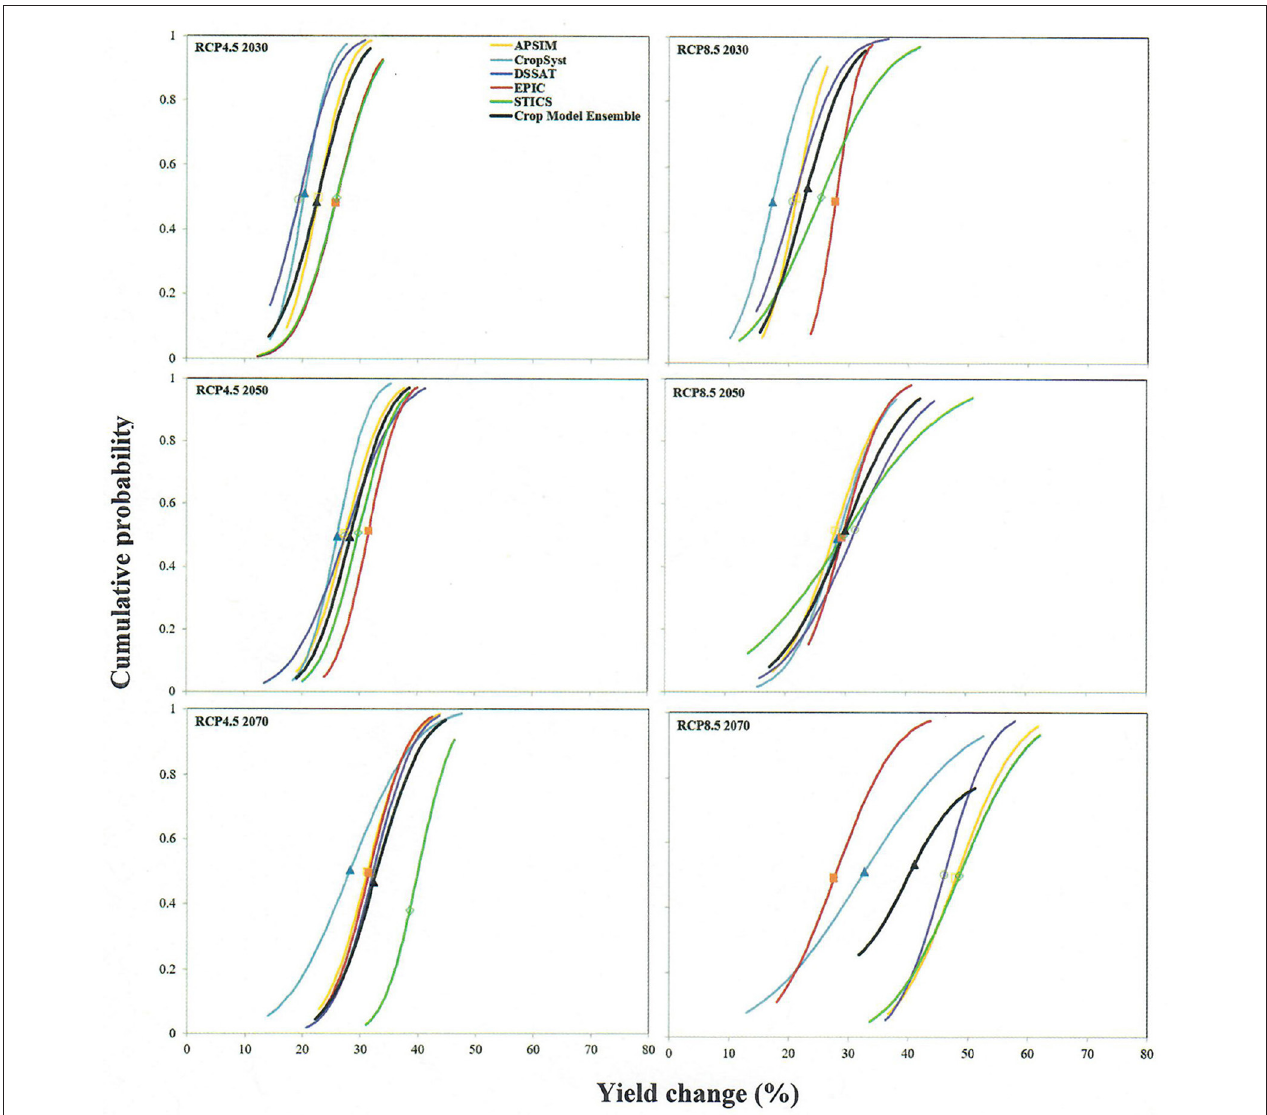
FIGURE 1 | Cumulative probability distribution for simulated winter wheat yield changes during three 31 year time periods, centered on 2030, 2050, and 2070, relative to the baseline period (1979–2010) under two representative concentration pathways (RCP4.5 and 8.5) and five crop models with ensembles of crop models at high rainfall site Pullman. Symbols on curves are at the curve’s inflection point and represent the most probable yield